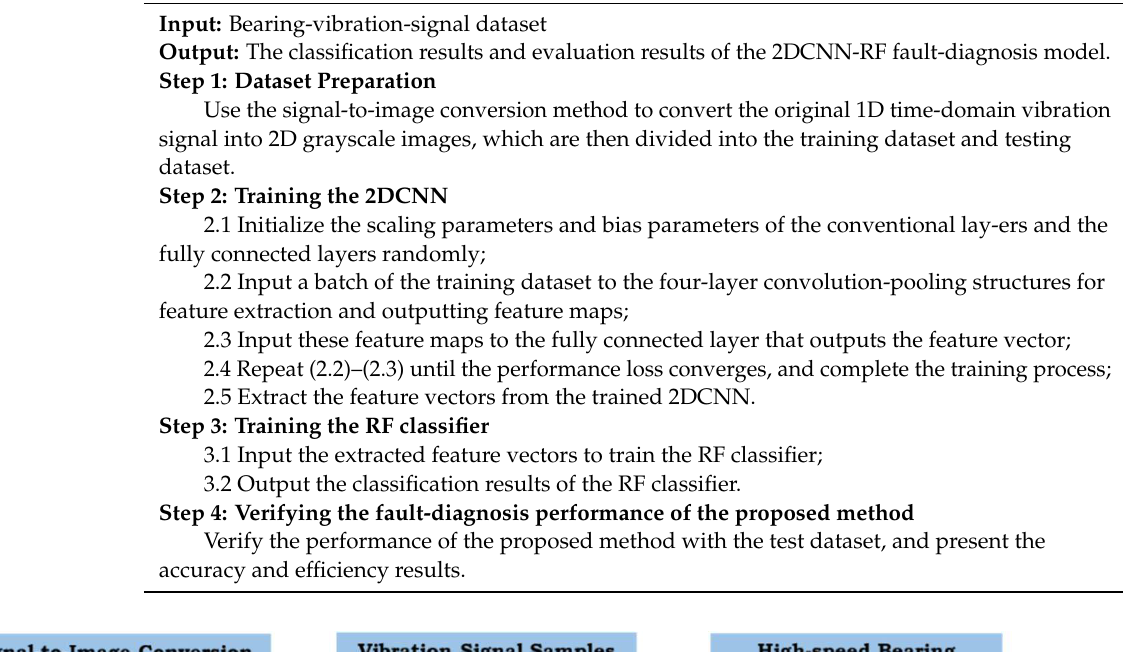
Algorithm 1 Steps of the implementation of the improved 2DCNN-RF model: